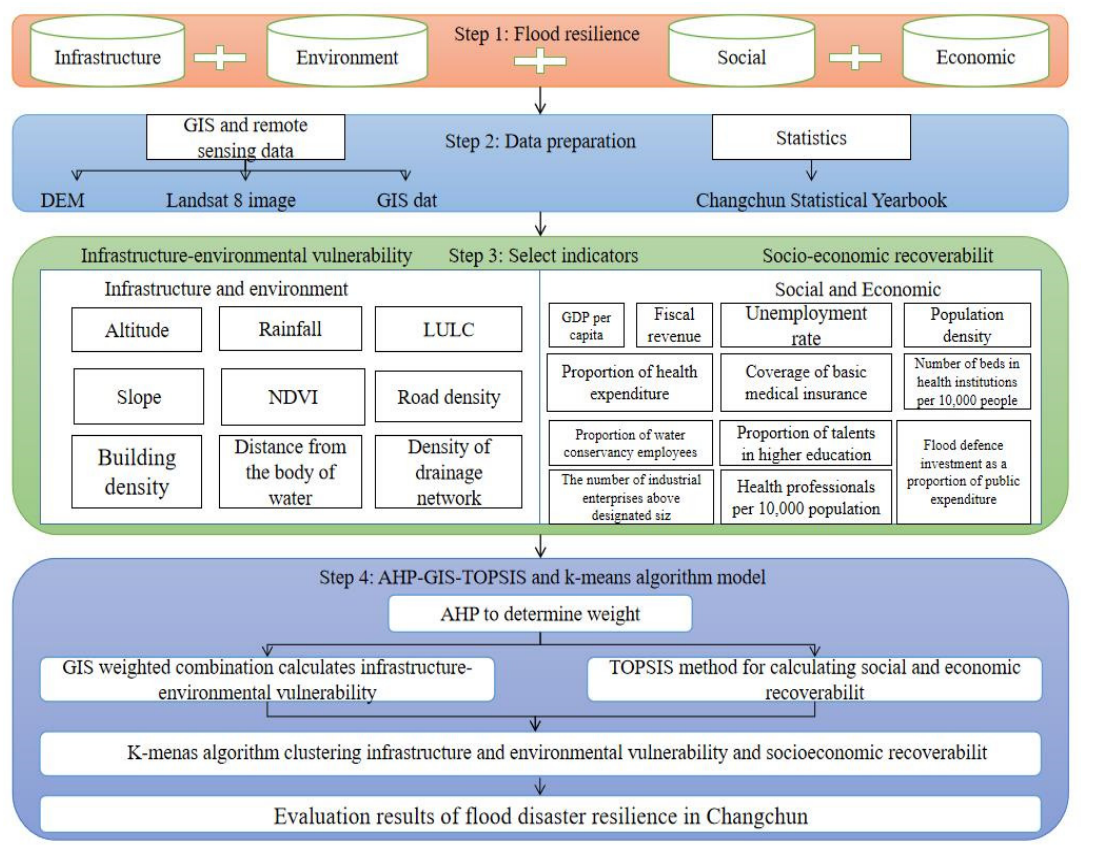
Figure 2. Flow chart of flood resilience evaluation.